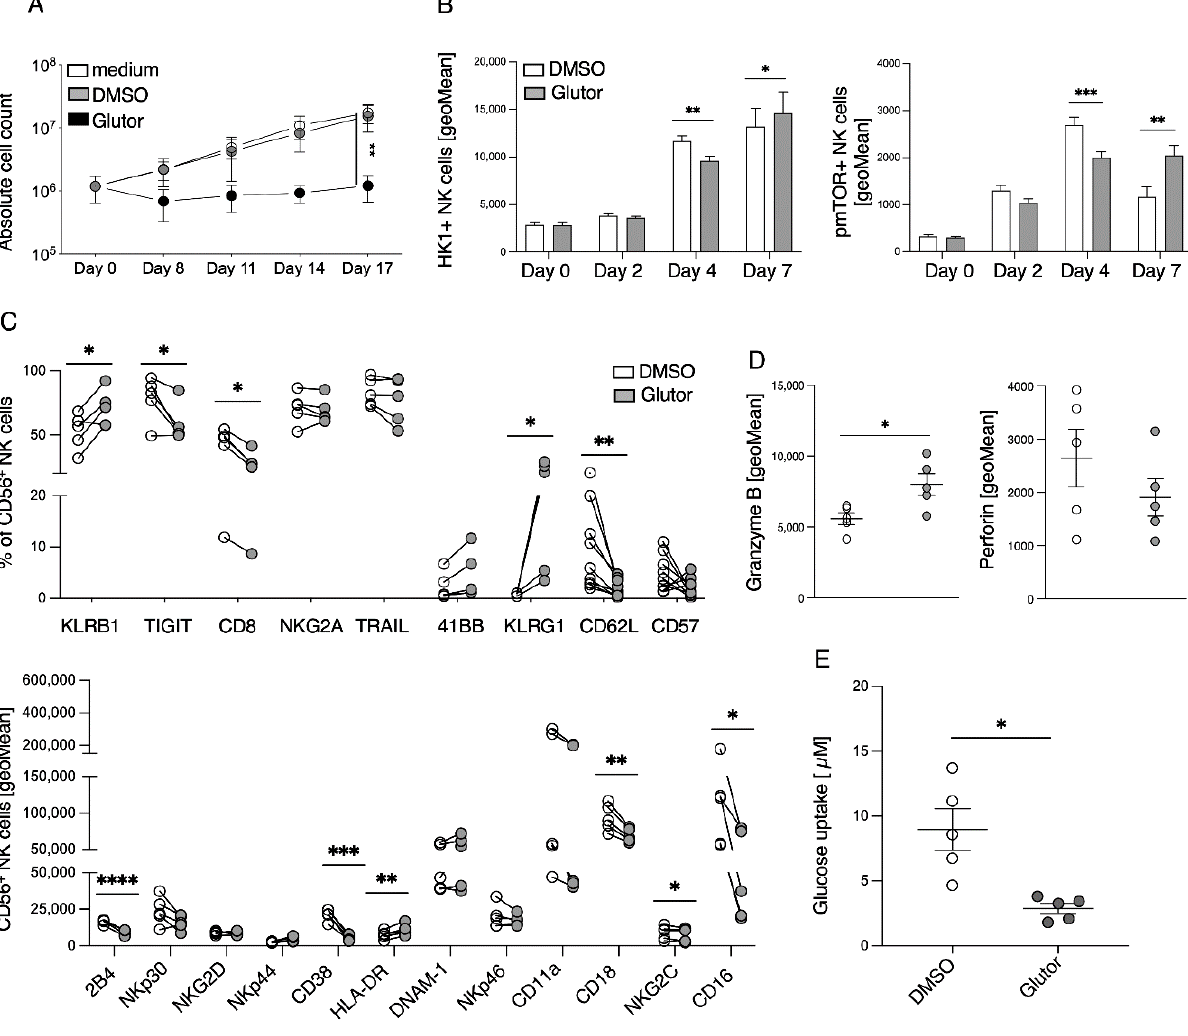
Figure 3. Long-term treatment with Glutor results in an altered phenotype and in a reduced pro- liferation of NK cells. ( A ) Proliferation of Glutor-treated (100 nM) in comparison to control-treated NK cells. Absolute cell count was calculated at indicated time points: n = 4. Data were pooled from four independent experiments and each experiment was performed with one donor. Mean with SEM. Statistics: paired t -test. ( B ) Expression level of HK1 and pmTOR on Glutor-treated (100 nM) and control NK cells was analyzed using flow cytometry at day 0, day 2, day 4 and day 7: n = 6. Data were pooled from four independent experiments and each experiment was performed with one donor. Mean with SEM. Statistics: paired t -test. ( C ) Expression level of several surface molecules